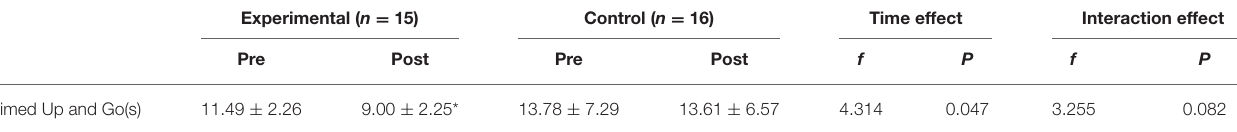
TABLE 4 | Timed Up and Go outcome measures before and after 12 weeks of